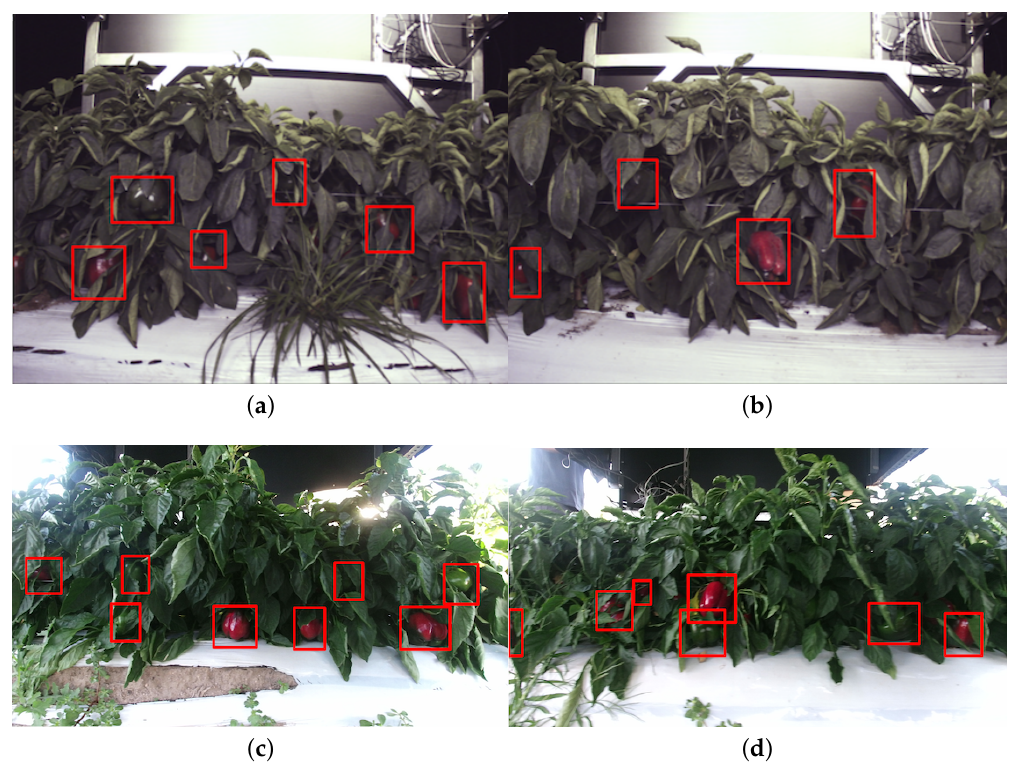
Figure 15. Four instances of sweet pepper detection. ( a ) and ( b ) are obtained from a farm site using a JAI camera, and ( c ) and ( d ) are collected using a Kinect 2 camera at a different farm site. Above each detection is the classification confidence output from the